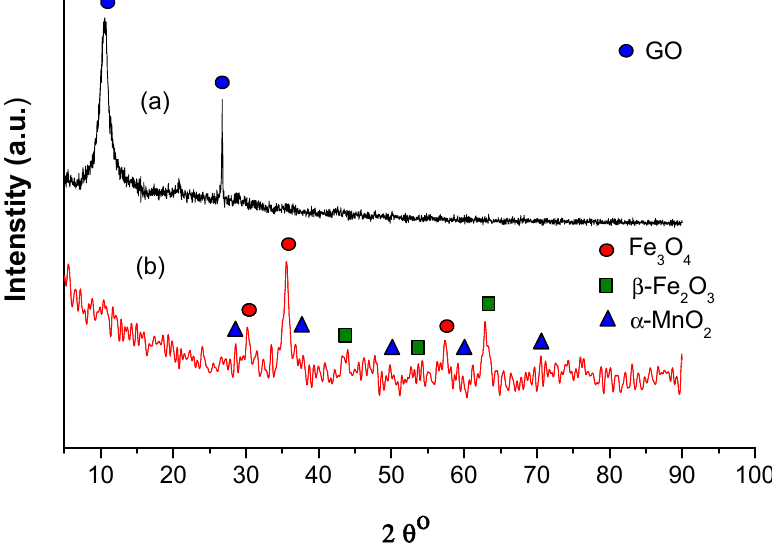
Figure 4. X-ray diffraction patterns (XRD) of ( a ) GO and ( b ) MnO 2 /MrGO .